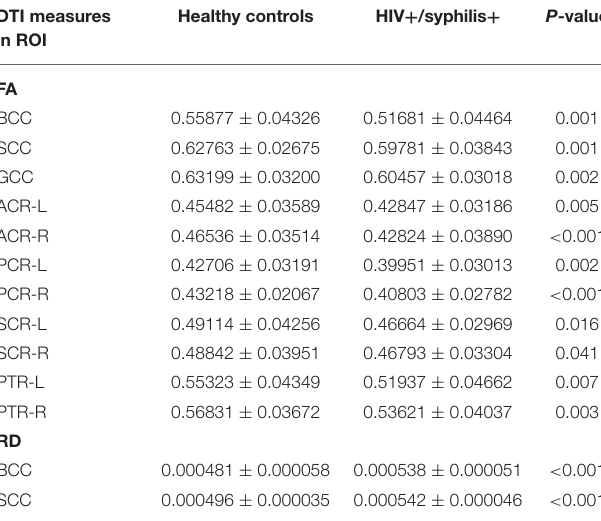
TABLE 2 | Comparison of DTI measures between healthy controls and HIV + /syphilis + in ROI-based analysis.